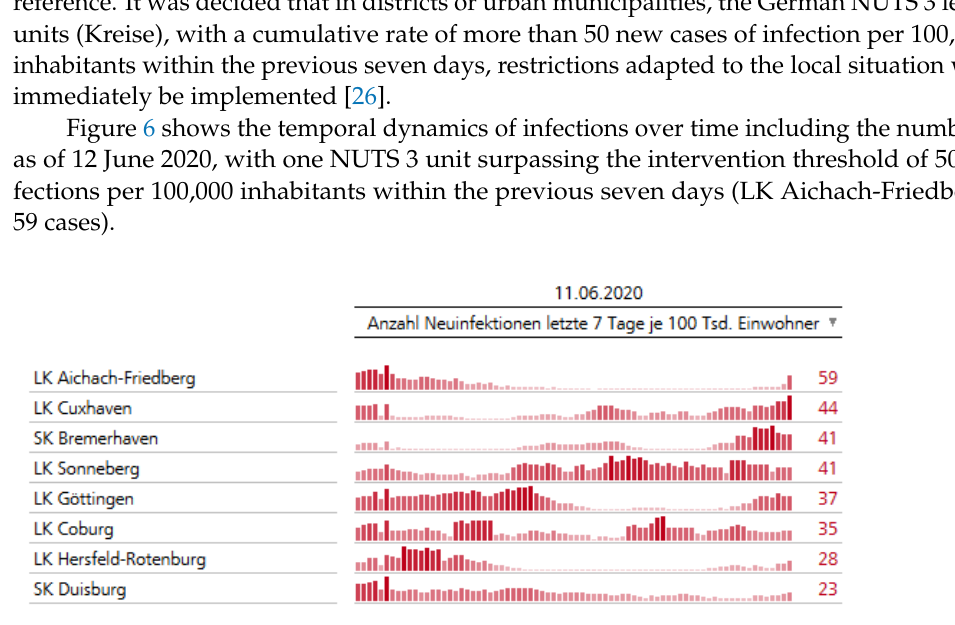
Figure 6. Dynamics of infections per 100,000 inhabitants in Germany at the Nomenclature of Terri- torial Units for Statistics (NUTS) 3 level [27].